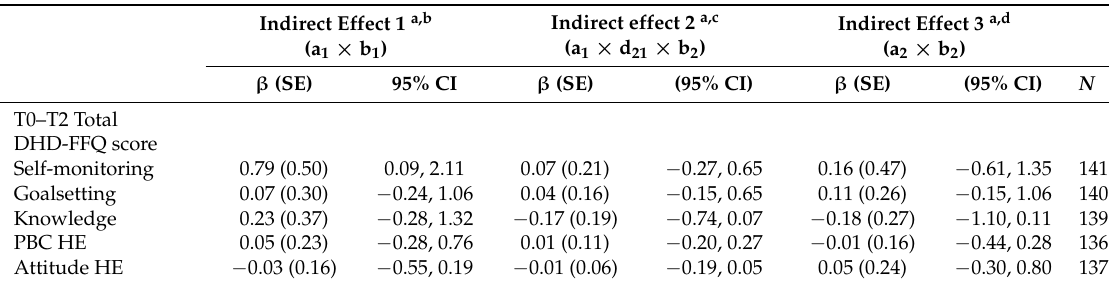
Mediation of the intervention’s effect on total diet quality score and other diet quality